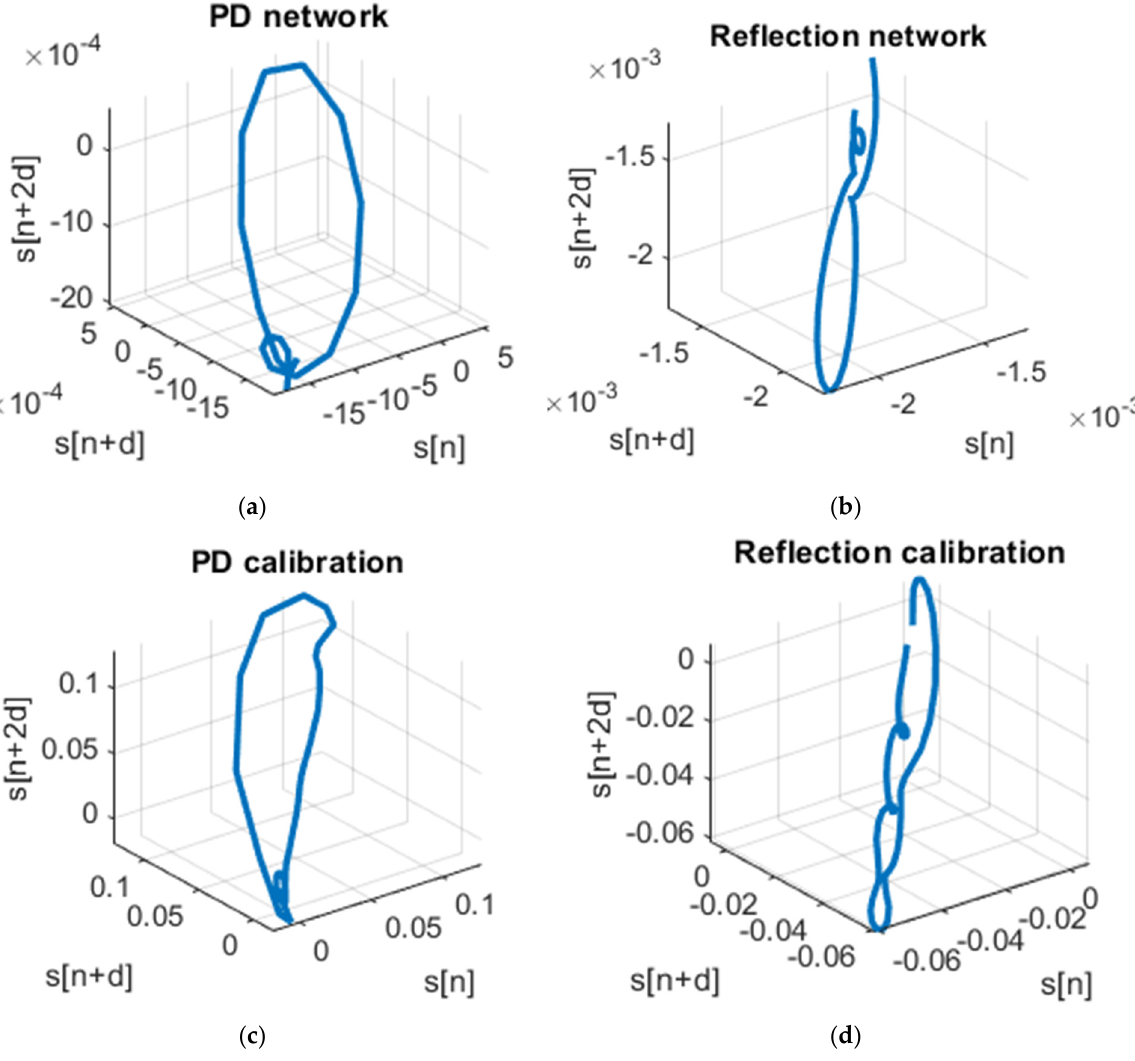
Figure 13. ( a ) Partial discharge from the network signal: d = 1, m = 3; ( b ) reflection of partial discharge from the network signal: d = 1, m = 3; ( c ) partial discharge from the calibration signal: d = 1, m = 3; ( d ) reflection of partial discharge from the calibration signal: d = 1, m = 3.